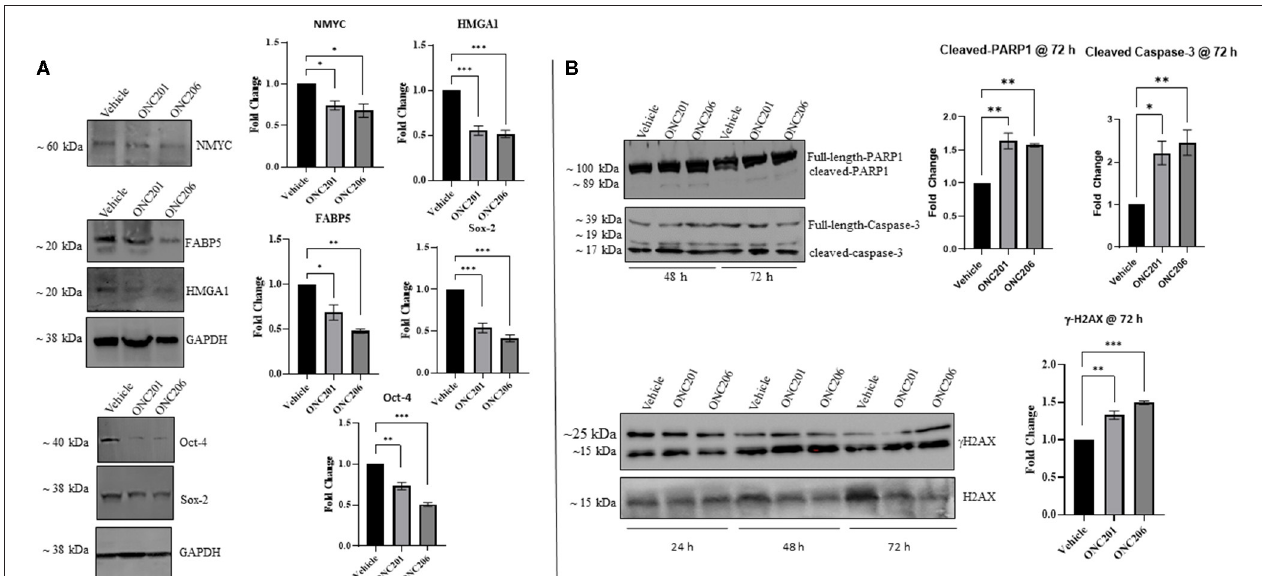
FIGURE 7 | ONC201/ONC206 treatment induces differential expression of tumorigenic proteins in IMR-32 NB cells. IMR-32 cells treated with either ONC201 (5 µ M) or ONC206 (0.5 µ M) exhibited significant reduction of tumorigenic protein expression compared with vehicle-treated cells as assessed using Western blot analyses. (A) Western blot quantitative analysis revealed significant downregulation in the protein expression of tumorigenic NMYC, FABP5, and HMGA1 as well as stem-markers Oct-4 and Sox-2, 48h after drug treatment. (B) Cleaved caspase-3, cleaved-PARP1, and γ H2AX were upregulated at 48 and 72h post-drug treatment. Blots without GAPDH loading control were quantitated using Bio-Rad’s stain-free gel technology and normalized to the total protein loaded per lane. Experiments were conducted in triplicates and repeated three times. Data represent the mean ± the standard error of the mean (SEM) of multiple experiments. * p < 0.05; ** p < 0.01; *** p <